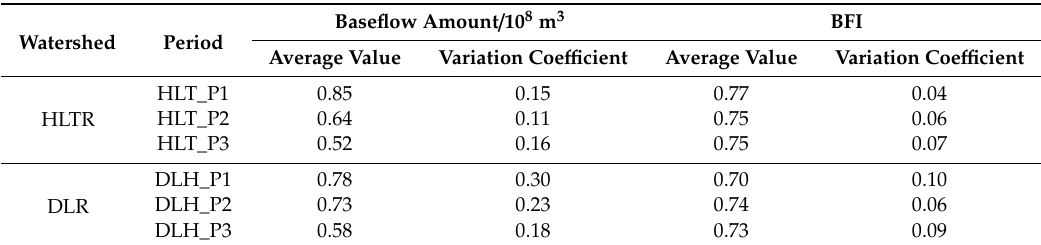
Table 2. Variation characteristics of two watersheds’ baseflow amount during three periods.